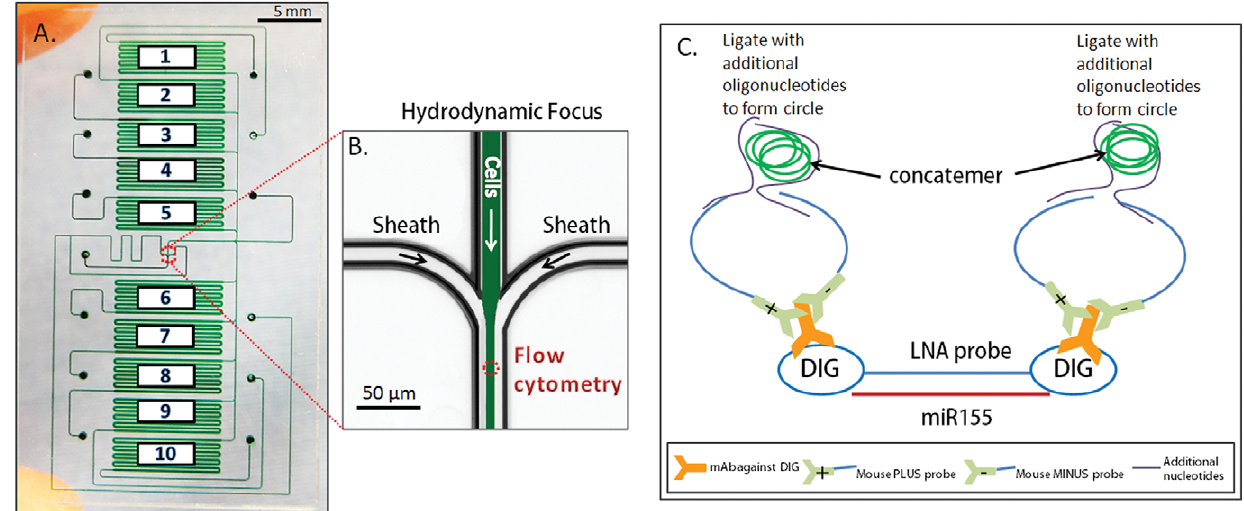
Figure 1. Microfluidic chip and LNA flow-FISH method schematic. A. 10-chamber microfluidic chip. Cells prepared in each of the holding chambers can be detached and driven to the center of the chip shown in B, for hydrodynamic focus and flow cytometry. The signal from miRNA155 hybridized to the LNA probe is amplified using RCA method depicted in C. The DIG label on both ends of the LNA probe is recognized by anti-DIG mAb, and two RCA probes ( + and -) bind to each anti-DIG mAb and are ligated to two additional oligonucleotides to form circular templates for rolling circle amplification. The resultant concatemer products can be visualized using microscopy as well as measured using flow cytometry.